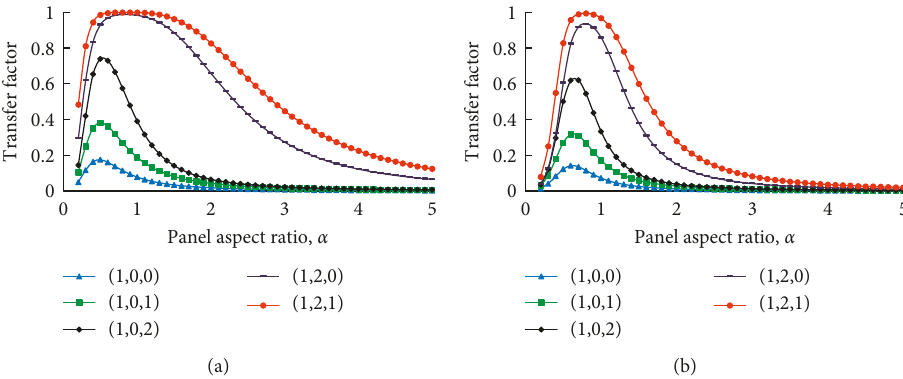
Figure 9: Effect of panel aspect ratio on the coupling property of the panel-enclosure coupled system with different panel boundary conditions: panel mode (2,3). (a) Simply supported panel mode (2,3). (b) Clamped panel mode (2,3).